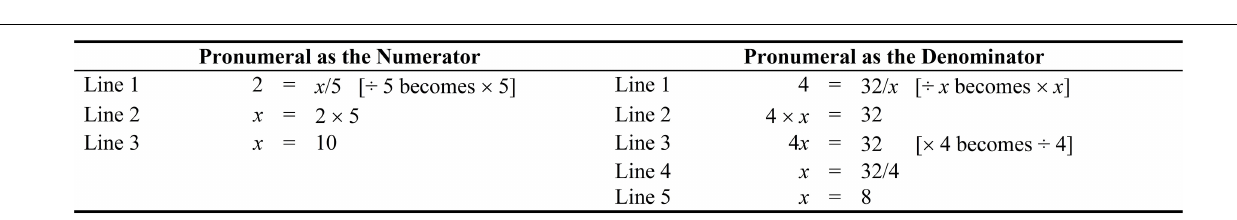
FIGURE 6 | A comparison between an equation with pronumeral as numerator and an equation with pronumeral as denominator.